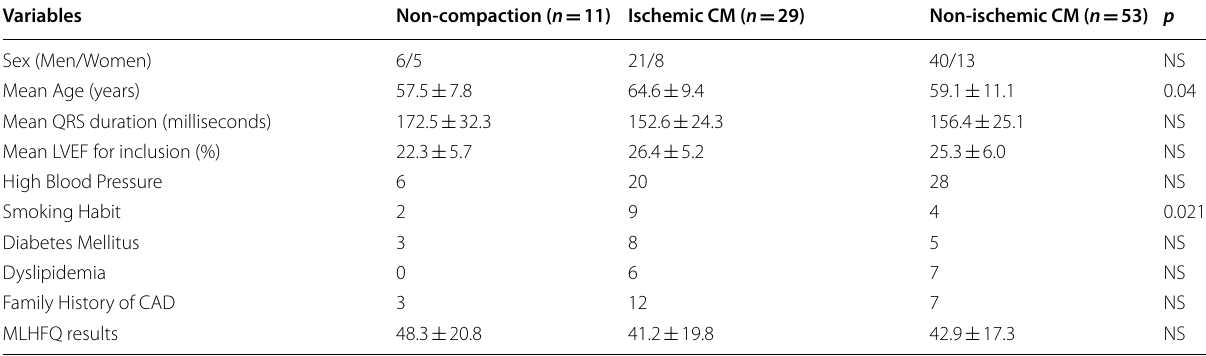
SD. The rest of variables are presented as the number ±